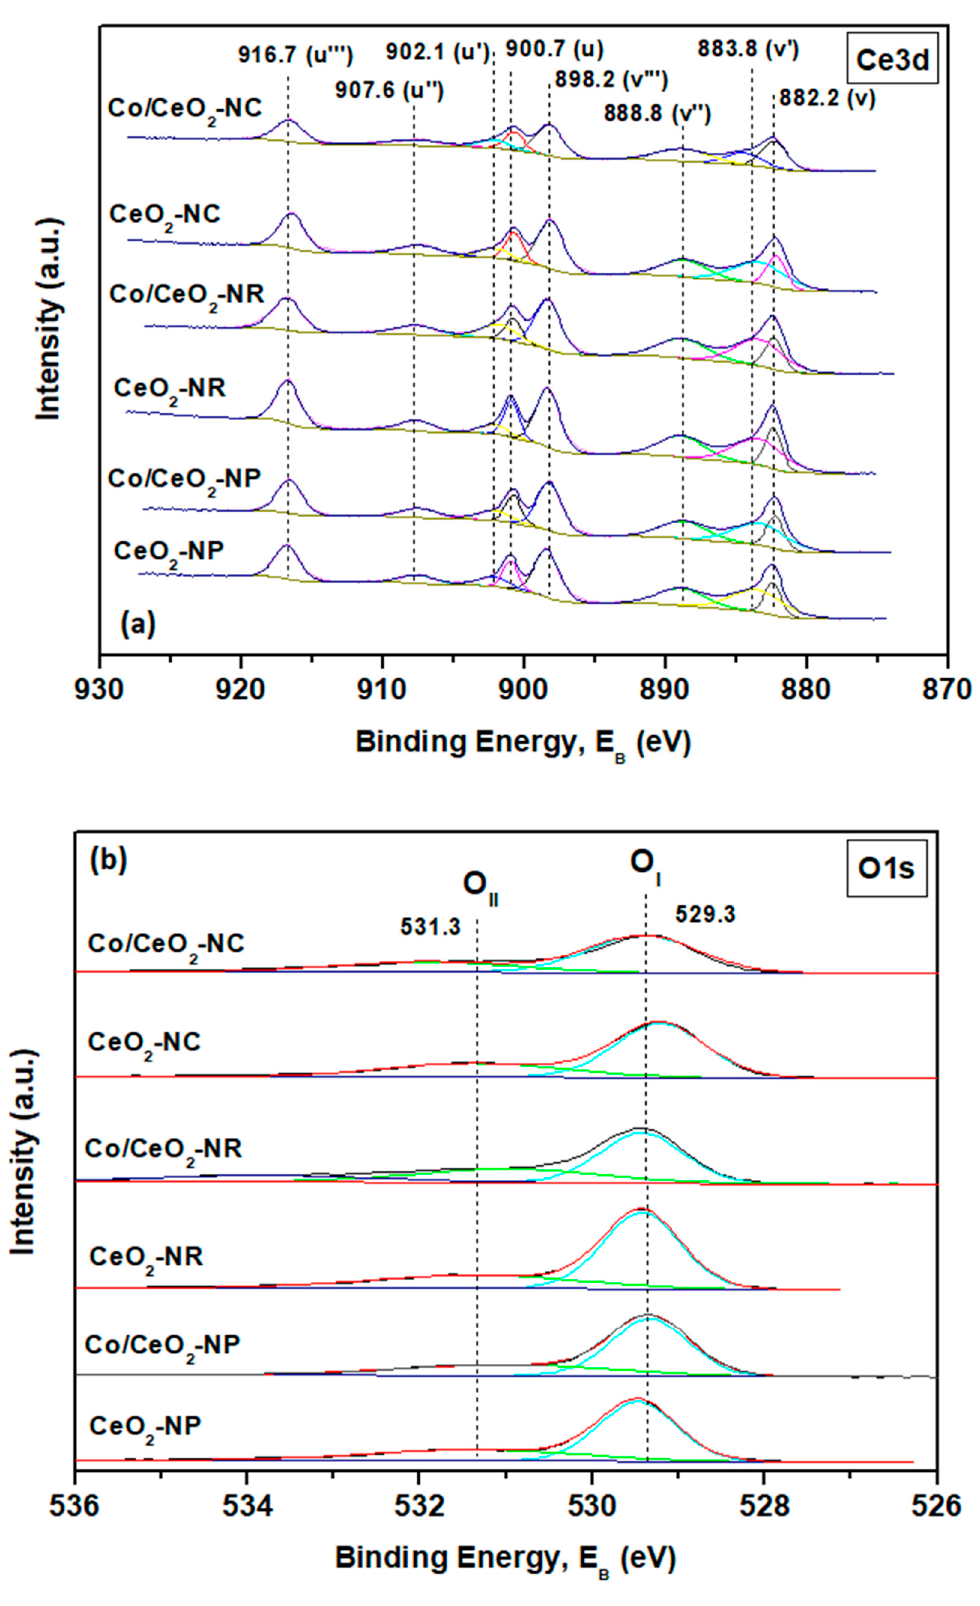
Figure 5. The X-ray photoelectron spectroscopy (XPS) spectra of ( a ) Ce 3d and ( b ) O 1s of bare CeO 2 and Co/CeO 2 samples.